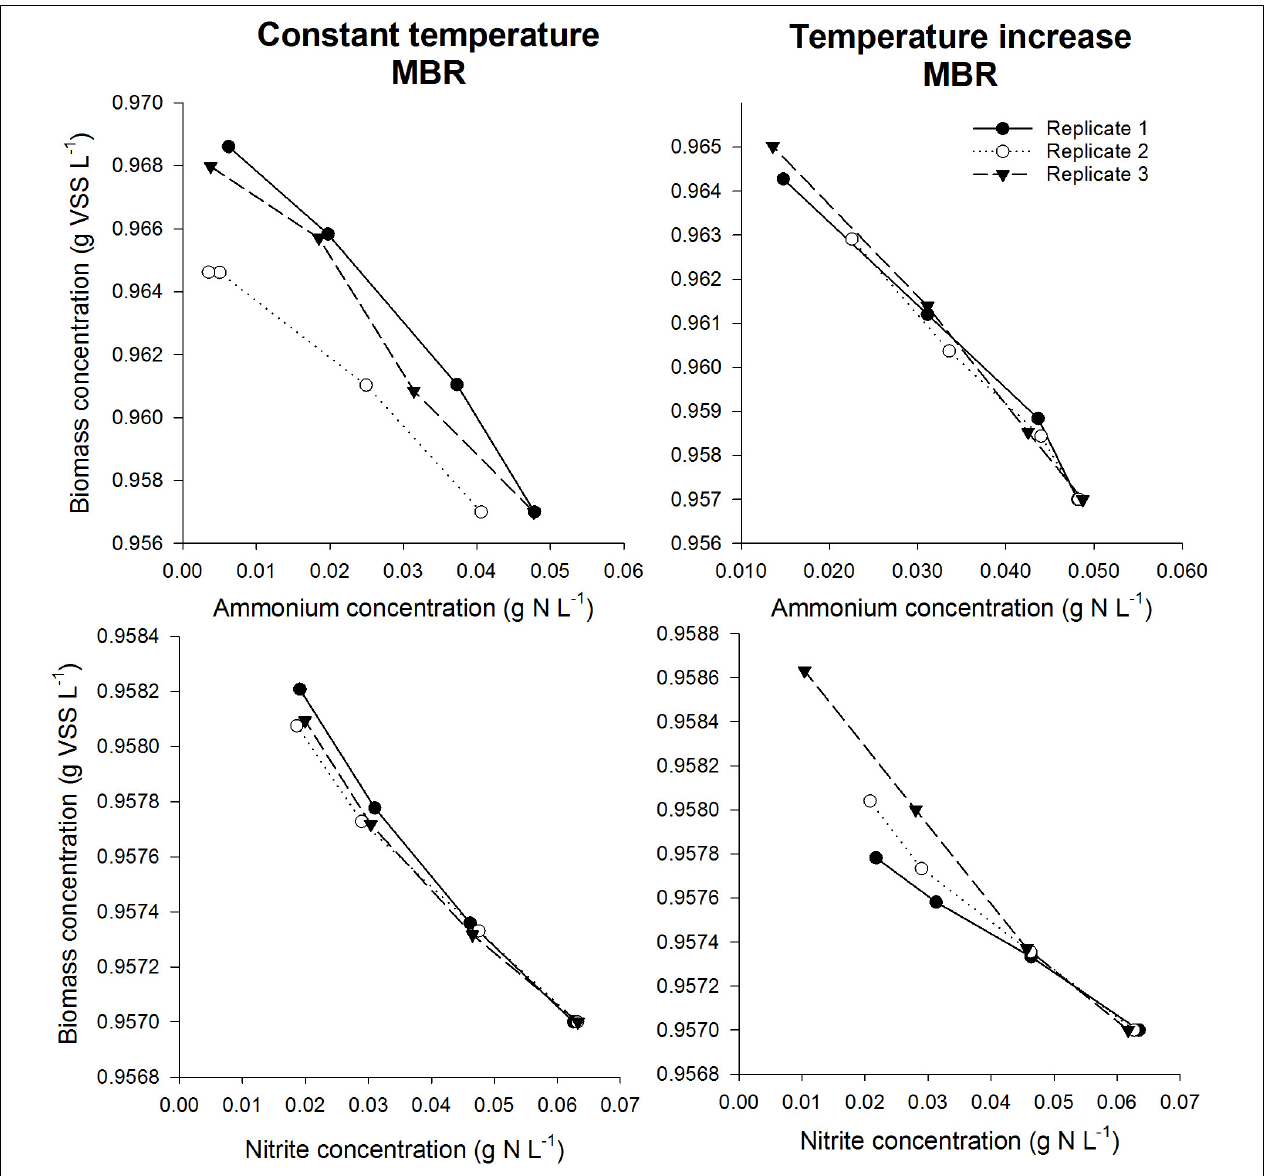
FIGURE 5 | Biomass concentration as a function of ammonium concentration (top) or nitrite concentration (bottom) during the incubations for the thermophilic inoculum in the constant temperature MBR (left) and the temperature increase MBR (right). The slope was used to determine the biomass yield for NOB in case nitrite was added as substrate, whereas the total AOA and NOB yield was obtained using the slope in case ammonium was added as substrate. By subtracting the NOB yield from the total yield, the AOA yield could be